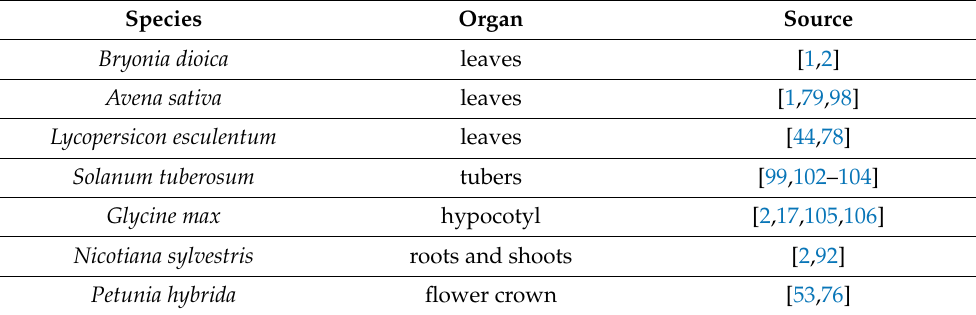
Table 1. JA biosynthesis as a result of mechanical damage. Species Organ Source Bryonia dioica leaves [1,2] Avena sativa leaves Lycopersicon esculentum